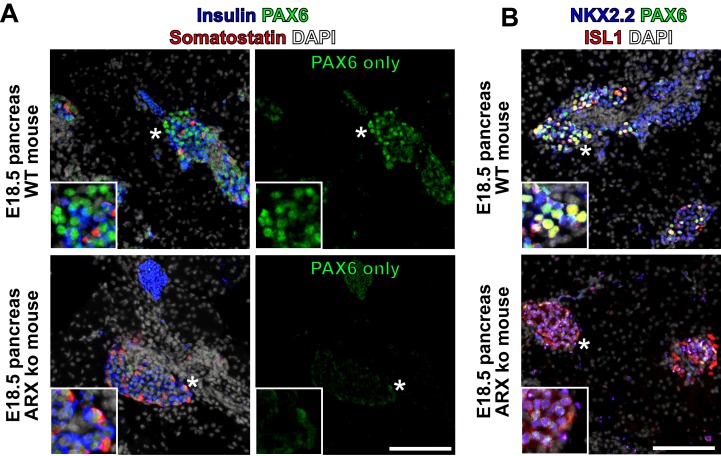
Expression of PAX6 in ARX ko mice.(A) Immunostaining of PAX6 (green), somatostatin (red), and insulin (blue) in ARX knockout (ARX ko) and wild type (WT) E18.5 mouse pancreatic samples. Image on the right shows individual PAX6 channel showing nuclear PAX6 in wild type islet cells and lower levels of PAX6 in ARX ko tissue. (B) Immunostaining of PAX6 (green), ISL1 (red), and NKX2.2 (blue) in the same samples as in A. Inset is a ~3x enlarged portion from the region indicated by the star. Scale bar is 100 μm for all panels.